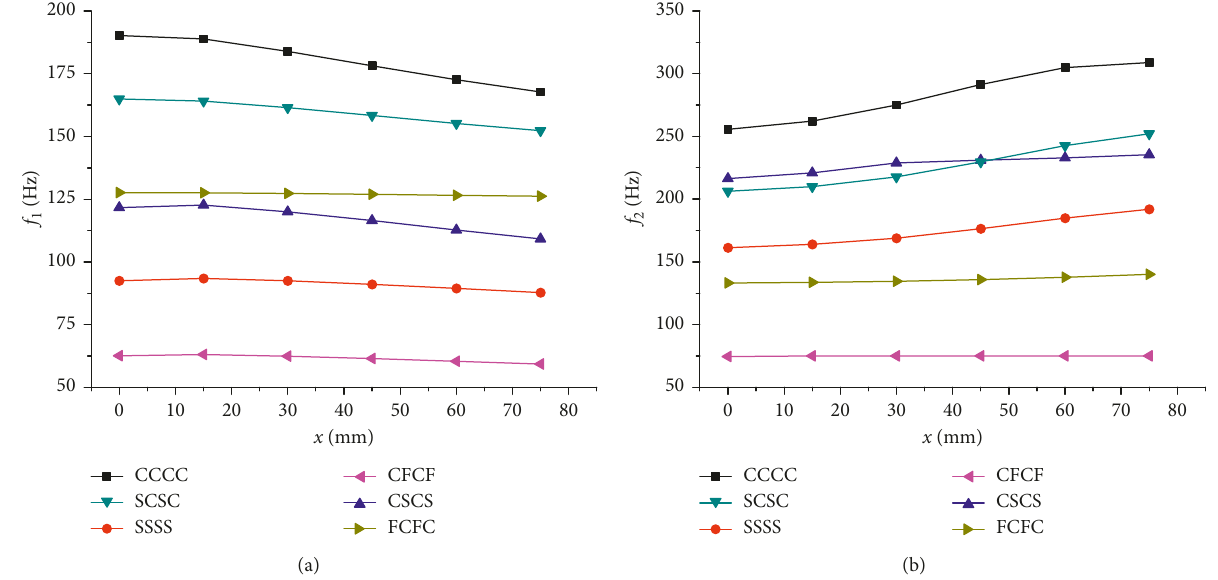
Figure 7: Variations of the natural frequencies of a rectangular plate supposed differently with various x . Table 5: Influence of cutout rotation on the first two frequencies of clamped-free plate.